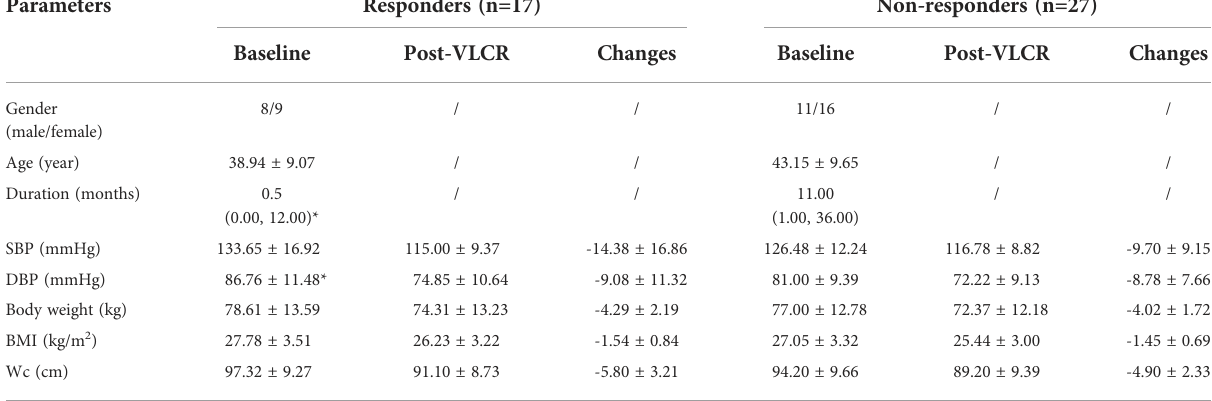
TABLE 2 Pre and post-VLCR anthropometric parameters in responders and